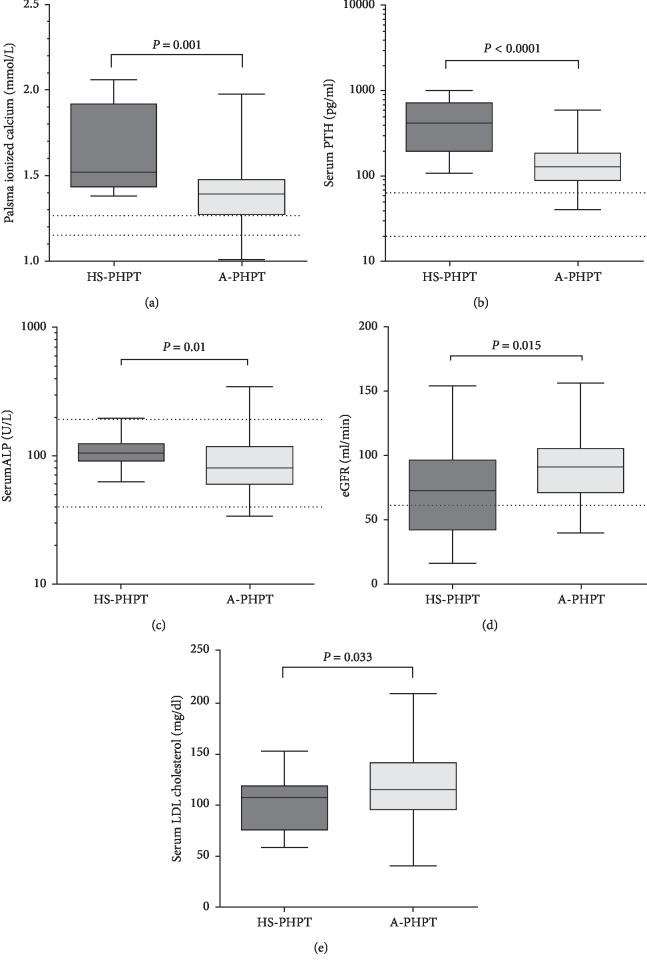
Differences in biochemical parameters between HS-PHPT and A-PHPT. Median plasma ionized calcium (a), serum PTH (b), serum total ALP activity (c), eGFR (d), and LDL cholesterol (e) significantly differed between HS-PHPT and A-PHPT patients. Dashed lines indicate normal reference ranges. Data are presented as median and range interquartile by box, and wisker plots represent minimum and maximum values. Statistical significance was determined by the Mann–Whitney test. HS-PHPT, hypercalcemic-related symptomatic PHPT (dark grey boxes); A-PHPT, asymptomatic PHPT (light grey boxes); PTH, parathormone; ALP, alkaline phosphatase; eGFR, estimated glomerular filtration rate; and LDL, low density lipoprotein.